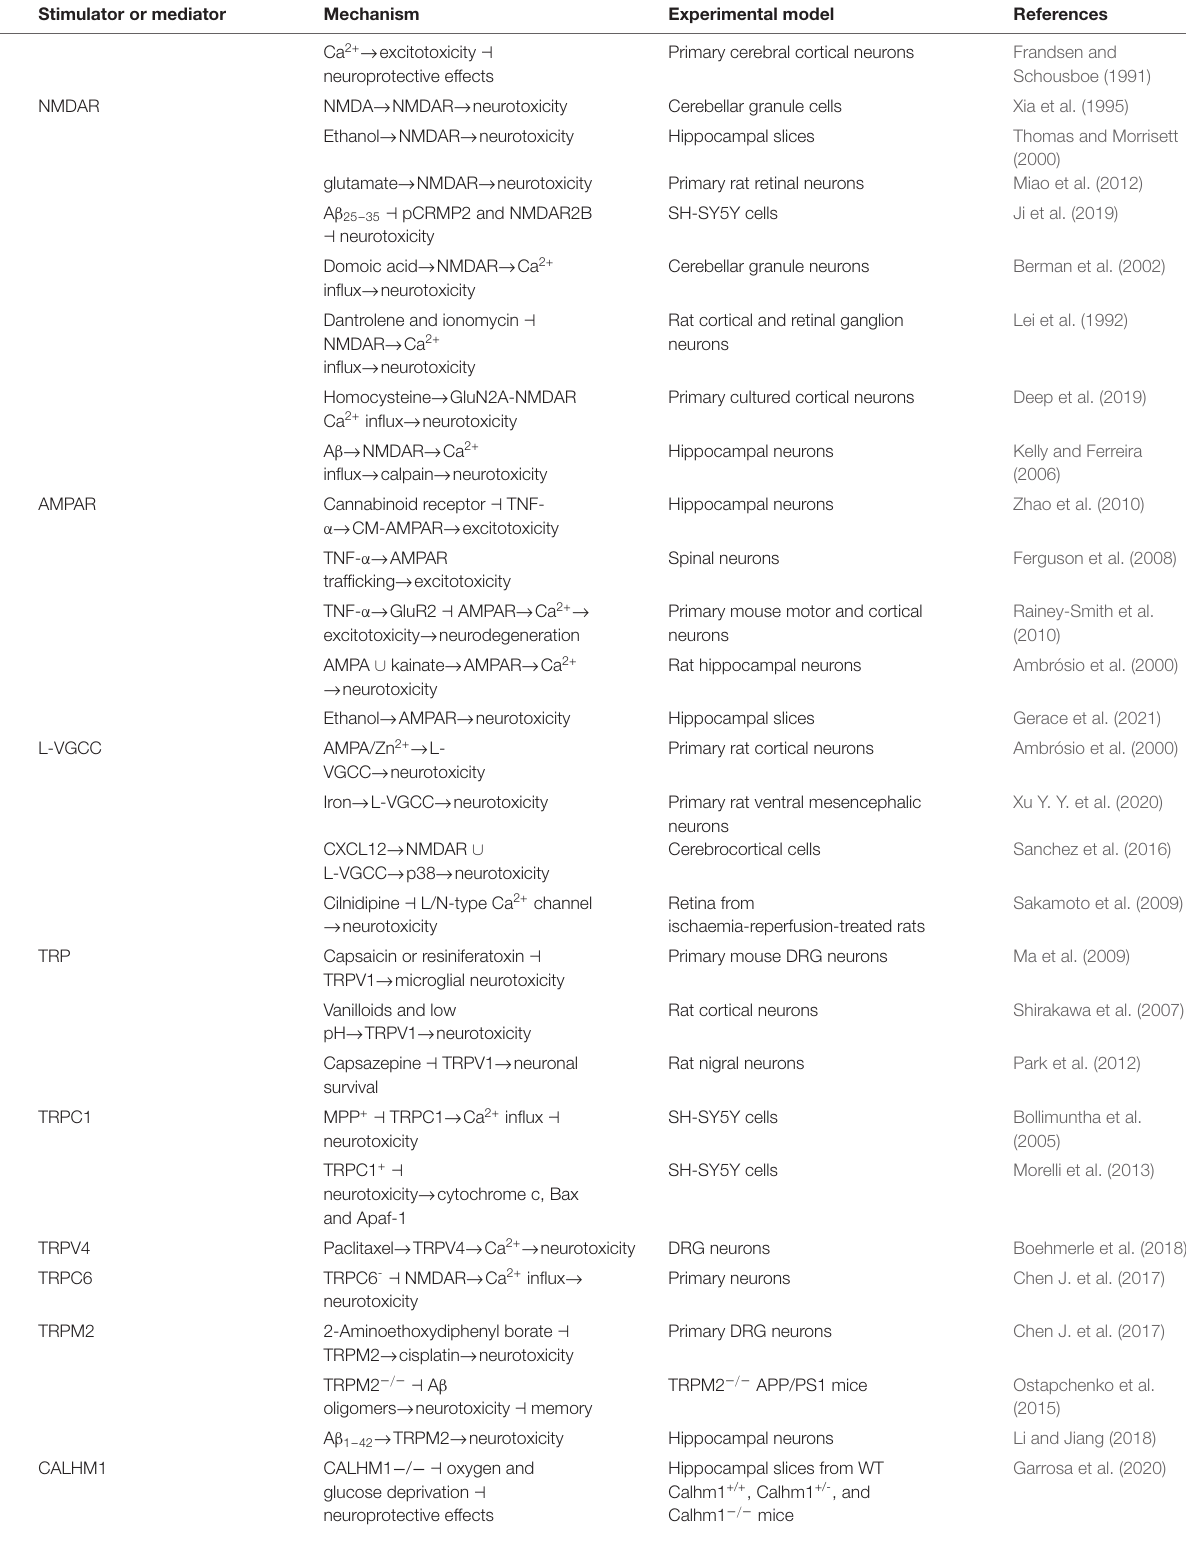
TABLE 4 | The effects of Ca 2+ on neurotoxicity (including neuroprotection).